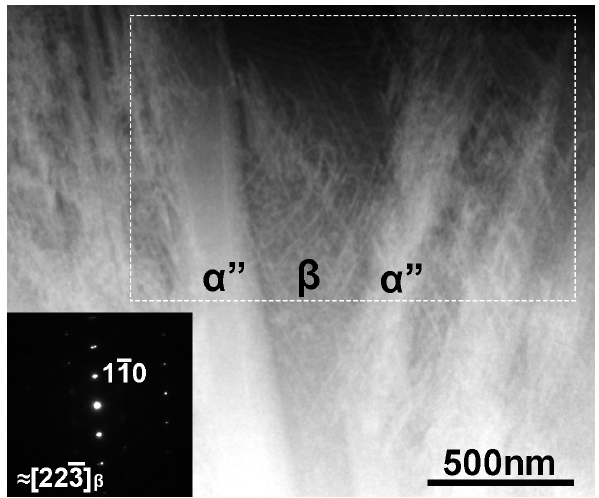
Figure 4. Magnified BF-STEM image and corresponding SAED pattern of the Ti–35mass%Nb alloy observed at a stage tilt of 0°. The image contrast is reversed in order to clearly show fine dislocations. The beam incidence is close to the [22 3 rectangular area indicated by dashed lines was selected for subsequent 3D